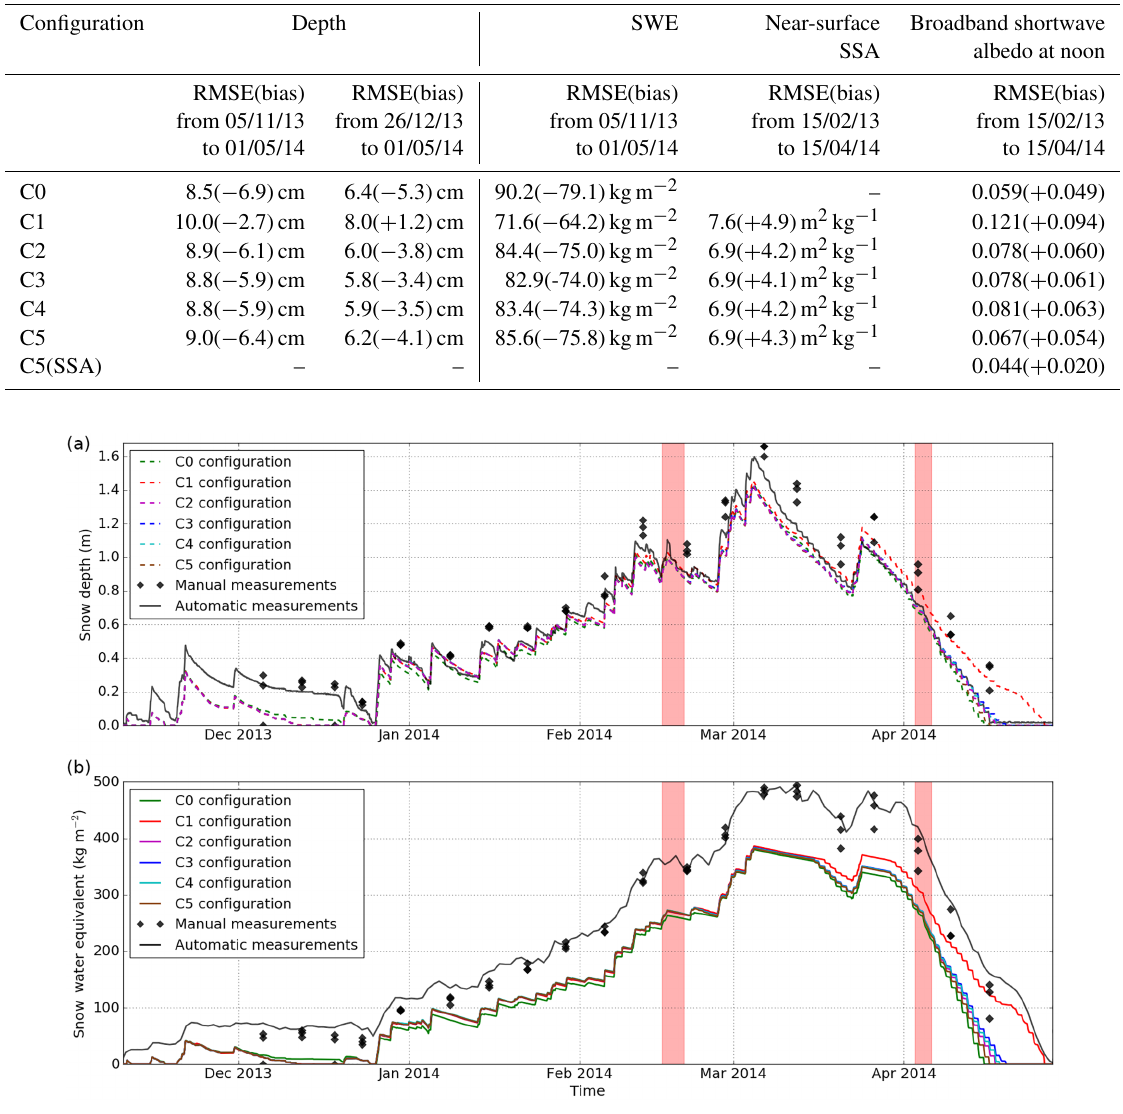
Table 2. RMSE and bias between measured and simulated variables. For snow depth and SWE, the RMSE and bias are computed from the automatic measurements. The SSA values are computed from the spectral albedo both measured and simulated. The spectral albedo computation is not activated in the reference Crocus version (C0), explaining the lack of RMSE and bias values for the corresponding box. Configuration